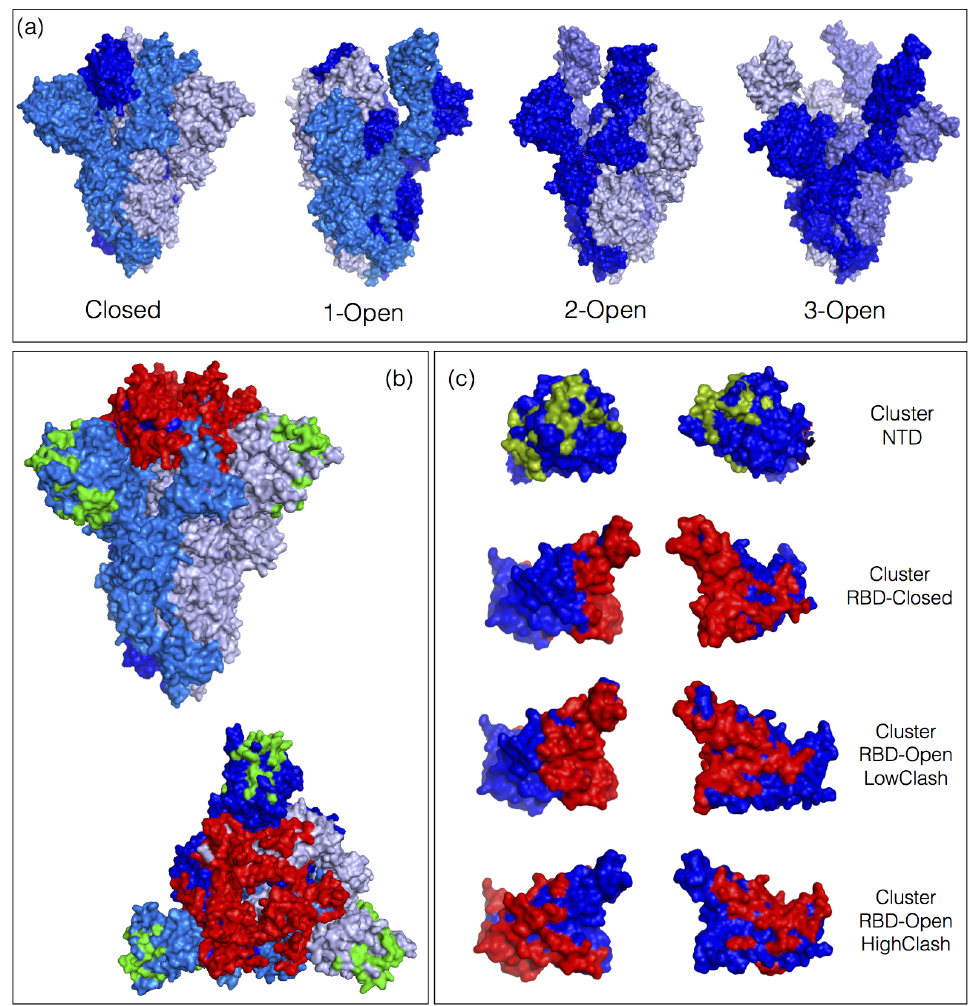
Figure 1. Spike protein conformations and epitopes. ( a ) 3D structure of the spike protein homotrimer in closed conformation (PDB code 6vxx), 1-open conformation (PDB code 6vyb), 2-open conformation (PDB code 6x2b) and 3-open conformation (PDB code 7cak). The three monomers are in different shades of blue. ( b ) Lateral and upper view of the 3D structure of the spike protein trimer in closed conformation (PDB code 6vxx). The ensemble of epitopes defined by the 83 neutralizing antibodies (nAbs) from the D nAb-spike dataset are colored in red and green according to whether they are situated on the receptor binding domain (RBD) or N-terminal domain (NTD). ( c ) NTD and RBD with the ensemble of epitope residues; the pairs of pictures are obtained by a 180° rotation around the vertical axis. The RBD epitopes are divided in three classes on the basis of the clash scores in the open and closed spike protein conformations (see Section